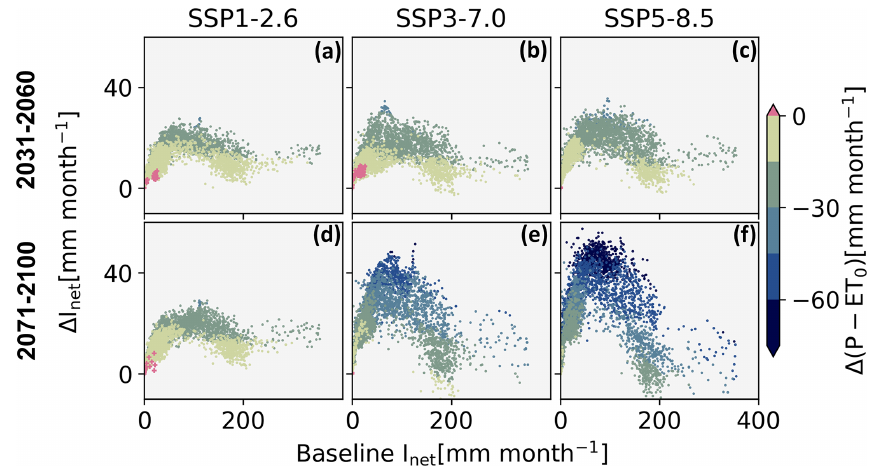
Figure 6. Scatterplots of (cid:49)I net relative to the baseline period for the two future periods (rows) and the three scenarios (columns). The coloring refers to the corresponding (cid:49) ( P –ET 0 ). Increases in (cid:49) ( P –ET 0 ) are represented by pink crosses. All values ( I net and (cid:49) ( P –ET 0 )) are medians across the GCMs (mm per